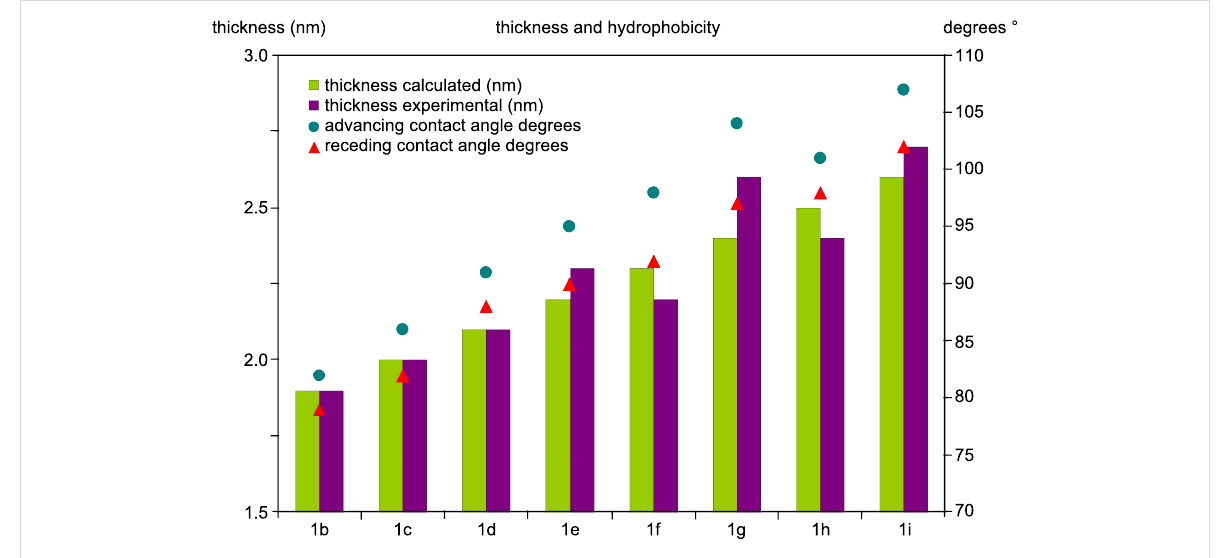
Figure 2: Thickness and contact angles (advancing/receding) for SAMs based on compounds 1b – i .